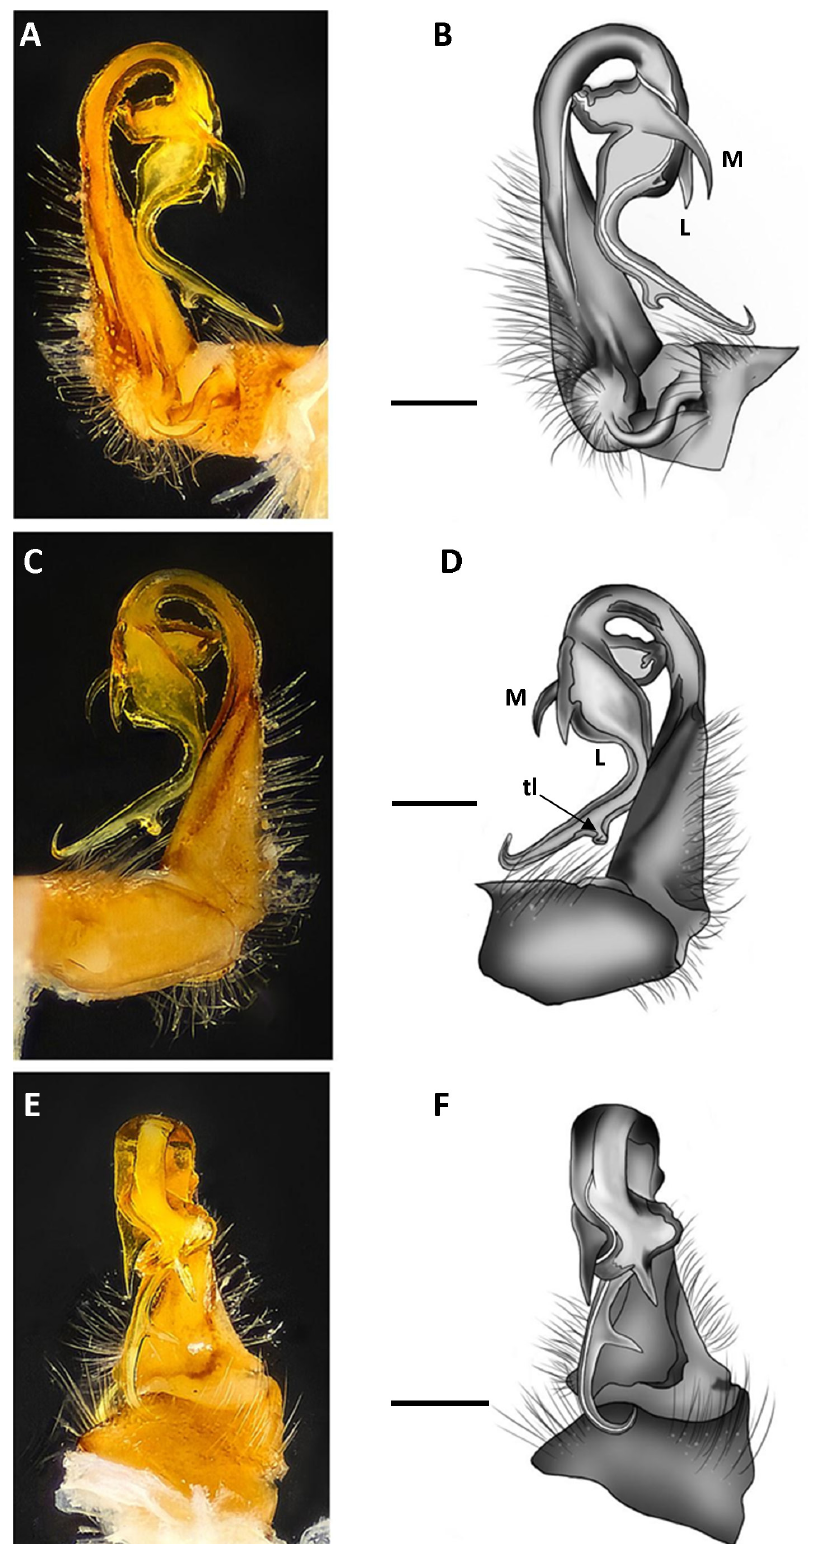
Fig. 9. Pogoro alopias Rosenmejer & Enghoff sp. nov., holotype, ♂ ( NHMD 621670), right gonopod. A–B . Mesal view. C–D . Lateral view. E–F . Dorsal view. Abbreviations: L = Process L; M = Process M; tl = triangular lobe. Scale bars: 0.5